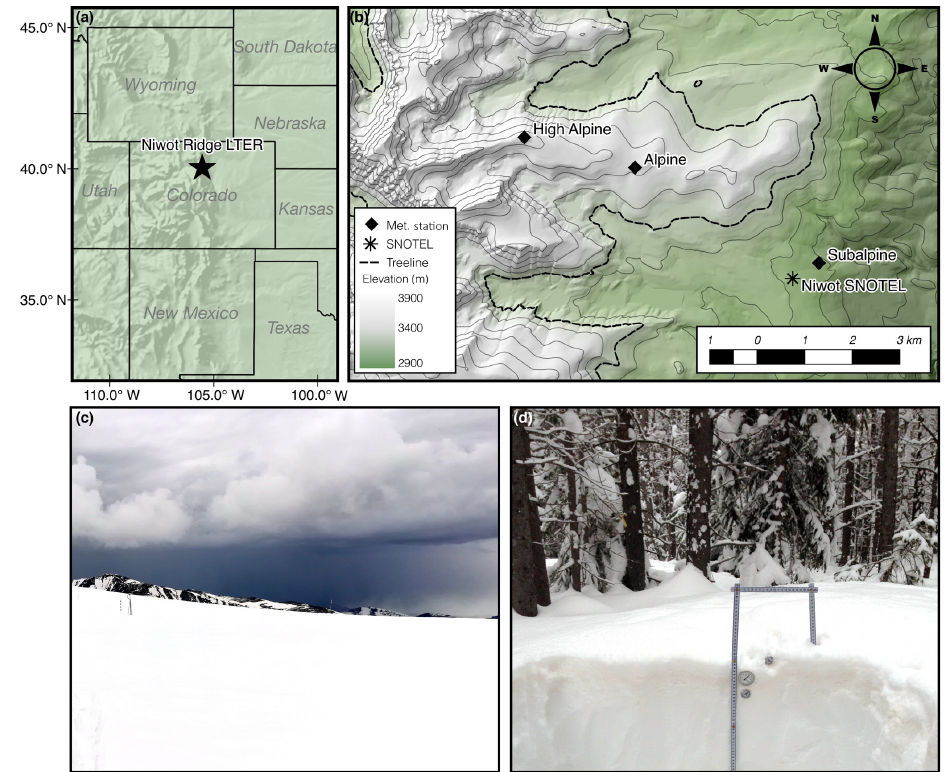
Figure 1. The location of the Niwot Ridge LTER within the western United States (a) and a topographical map showing the meteorological stations and snow pit sites. The dashed line in the LTER inset (b) represents the approximate treeline (3400m) and the thin, solid lines are 100m contours. The snow study focused on the alpine (c) and subalpine sites (d) , the two locations which have co-located snow pit observations and meteorological stations. The high alpine site was used as an additional station in the meteorological data infilling protocol and the Niwot SNOTEL was used for model